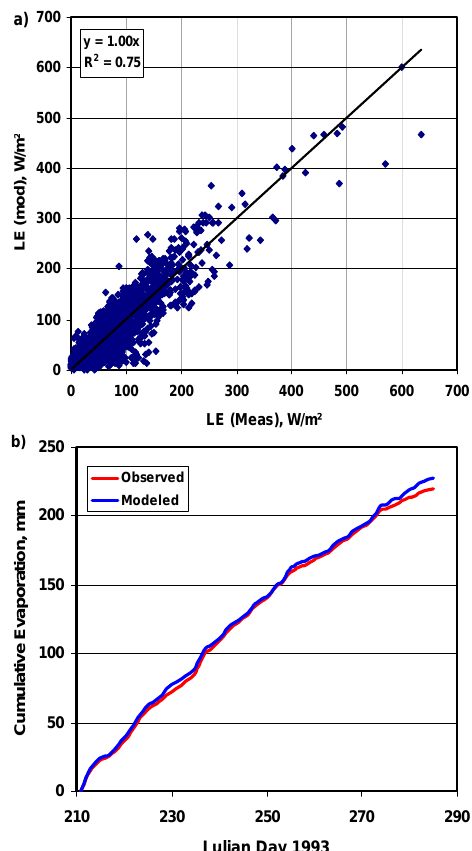
Fig. 10. Comparison between the measured and calculated evapo- Figure 10. Comparison between the measured and calculated evaporation from Quill Lake, ration from Quill Lake, 1993; (a) hourly evaporation rates, W/m 2 ; (b) cumulative evaporation, 1993; a) hourly evaporation rates, W/m²; b) cumulative evaporation, mm .